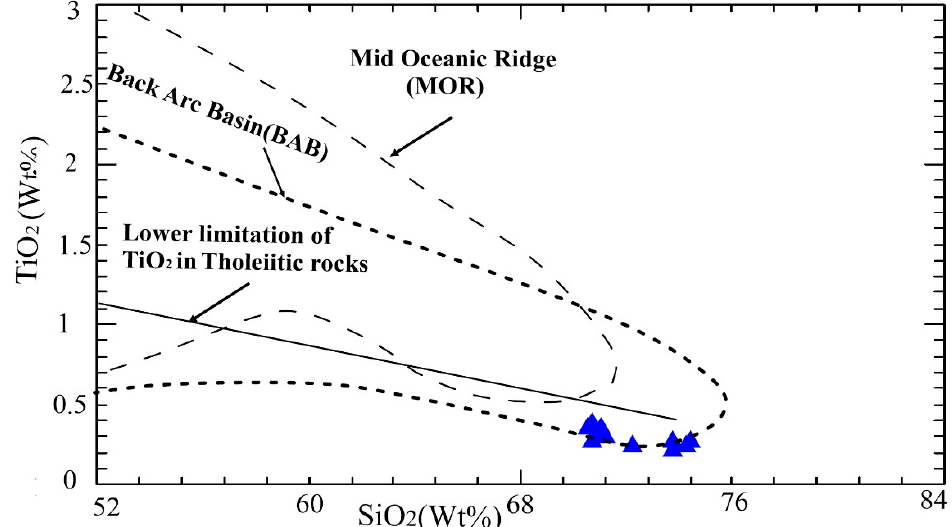
Figure 10. TiO 2 versus SiO 2 the samples plot near the border of magma differentiation and melts released from partial melting [66].